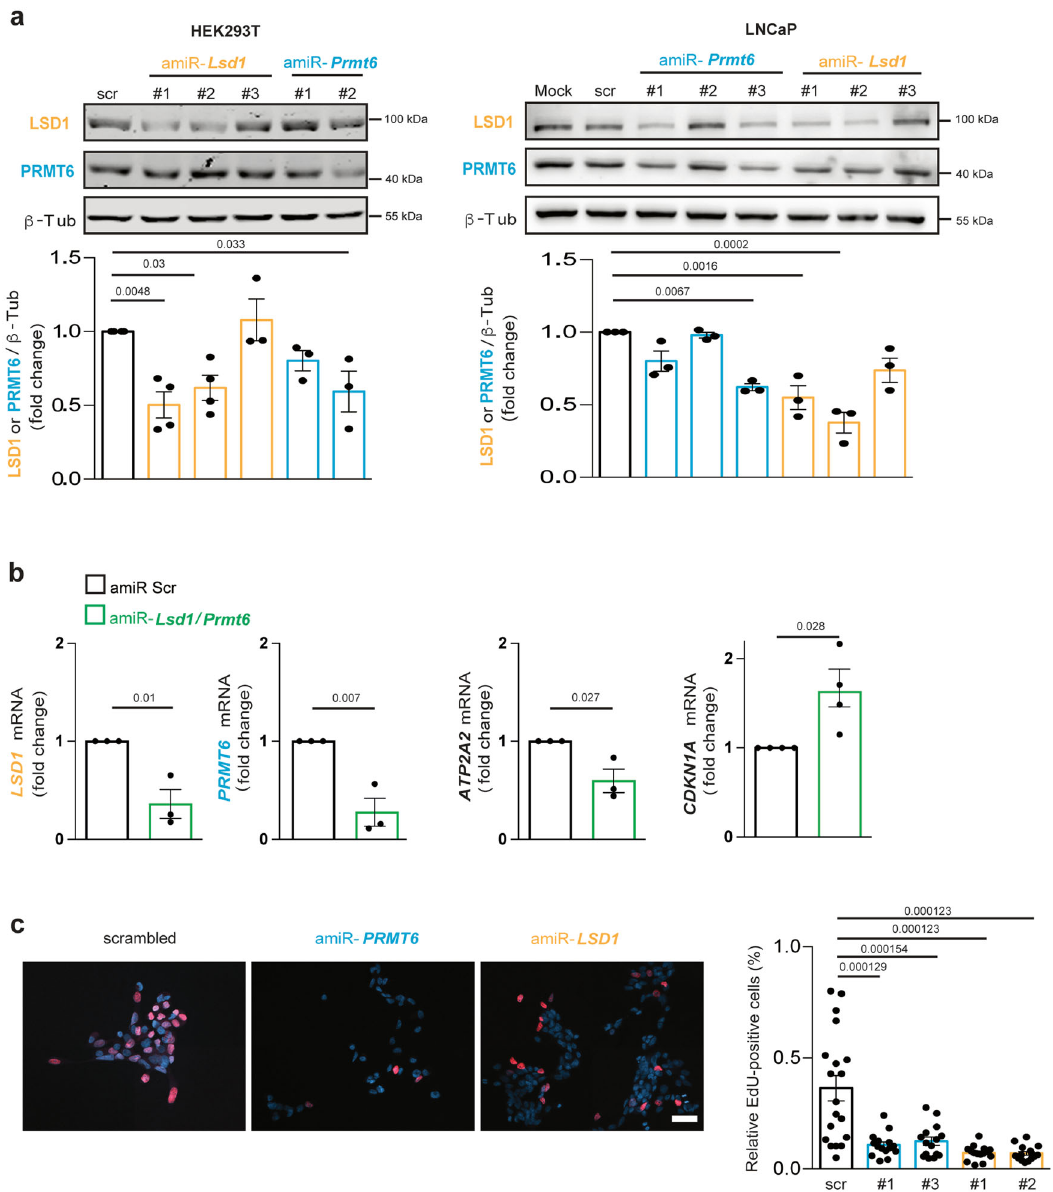
Fig. 9 | Silencing of human LSD1 and PRMT6 modi fi es gene expression and prostate cancer cell proliferation. a Western blots of LSD1 and PRMT6 in HEK293T and LNCaP cells transfected with vectors expressing scramble amiR or amiR- LSD1 and amiR- PRMT6 . Shown is one representative experiment. HEK293T cells: n =4 biological replicates for scramble, amiR -LSD1 #1 and amiR- LSD1 #2; n =3 biological replicates for amiR- PRMT6 #1 and amiR- PRMT6 #2. LNCaP cells: n =3biologicalreplicatesforalltheconditions.Quanti fi cationofthelevelsof LSD1 (yellow) and PRMT6 (blue) is shown at the bottom. b RT-PCR analysis of the